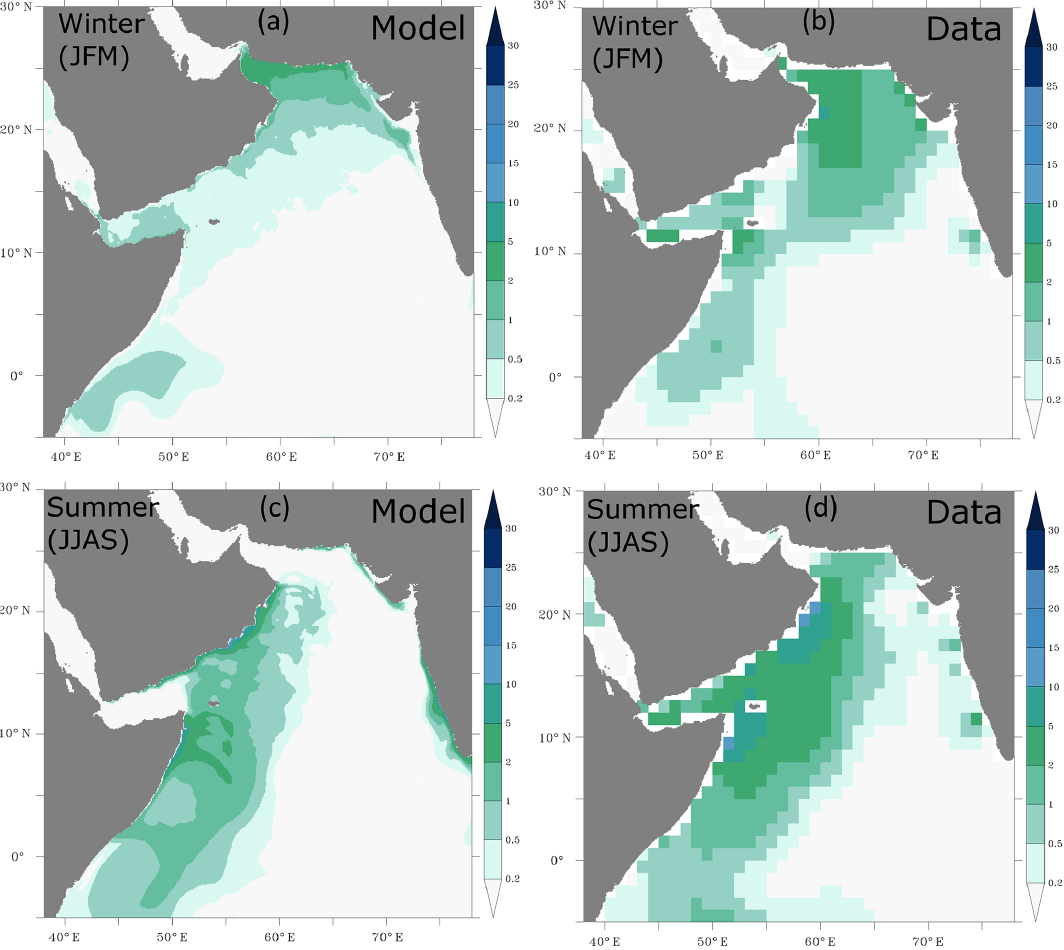
Figure A7. Surface distribution of nitrate. Surface distribution of nitrate (in mmolm − 3 ) as simulated in ROMS (a, c) and from the World Ocean Atlas (2009) dataset (b, d) during winter (a, b) and summer (c, d) months.